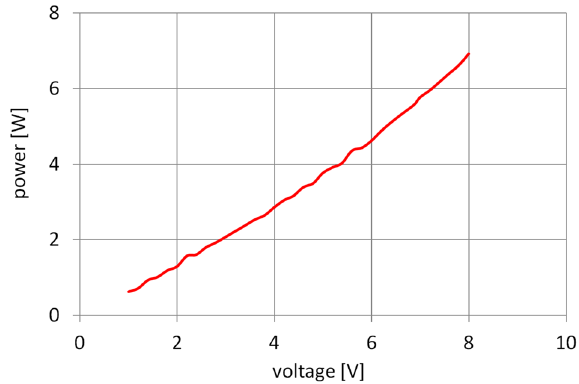
Figure 10. Power losses in the gearset operating at an ambient temperature.